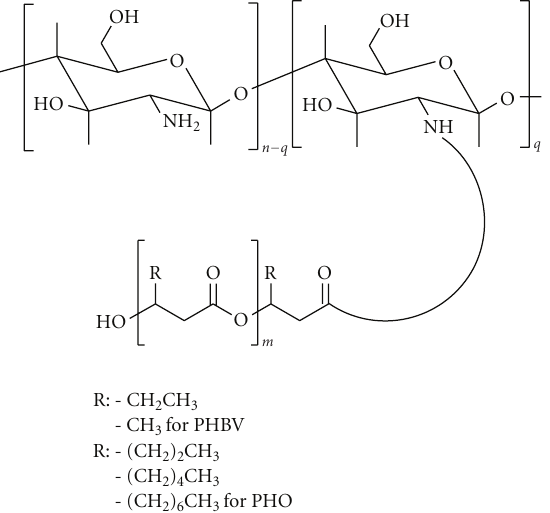
Figure 6: Chitosan-g-PHBV graft